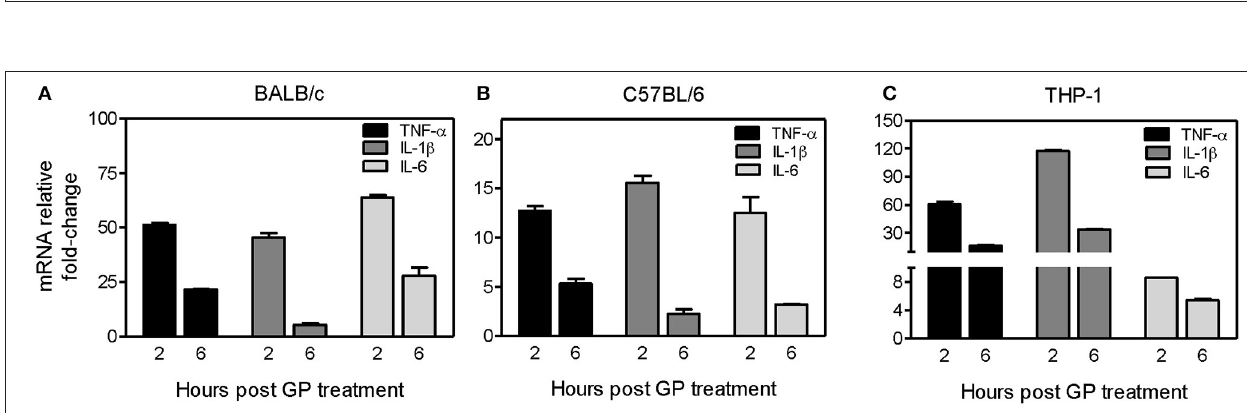
Frontiers in Microbiology |